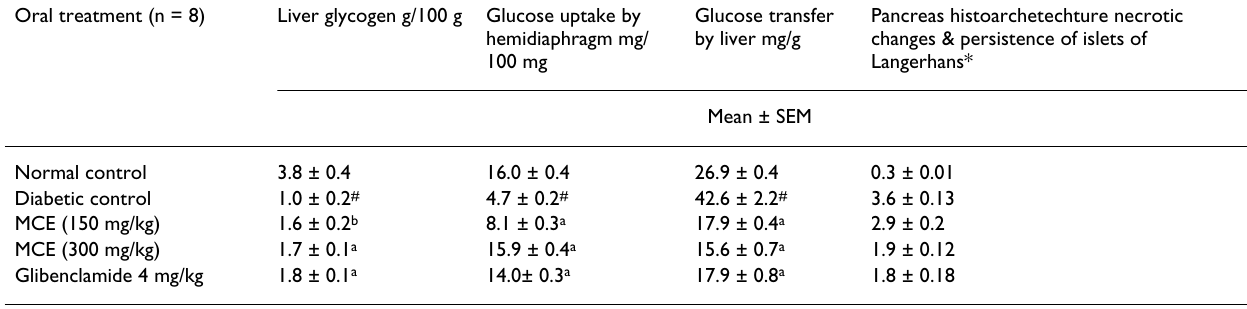
Table 2: Effect of Momordica charantia extract on liver glycogen levels, glucose uptake by hemidiaphragm and glycogenolysis by liver of alloxan diabetic rats Oral treatment (n = 8)